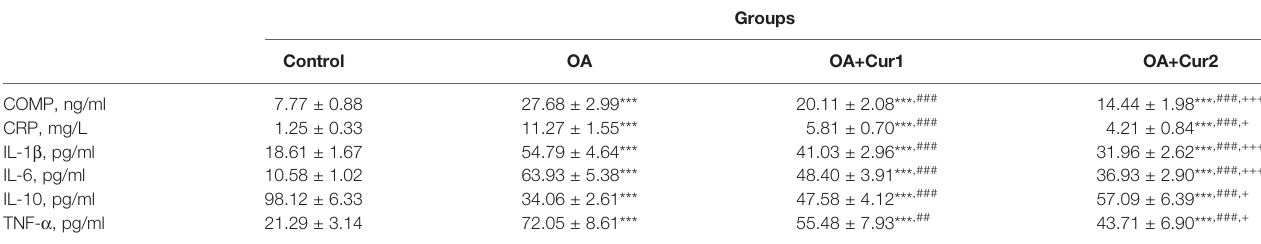
TABLE 3 | Effects of NGUC supplementation on serum in fl ammation markers in rats with monosodium iodoacetate (MIA)-induced OA.